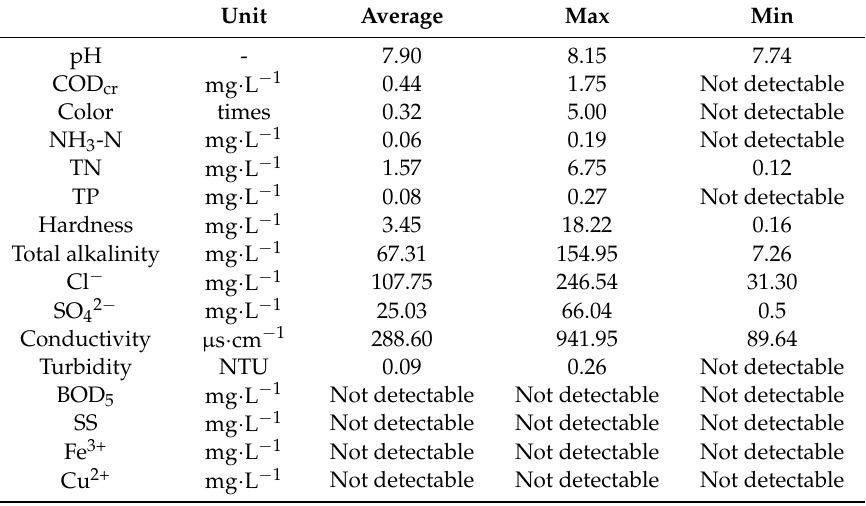
Figure 11. Average removal rates of pollutants for the RO concentrated water by the third sand filtration + second UF + second RO. Table 4. Pollutants of the effluent after the second RO treatment .